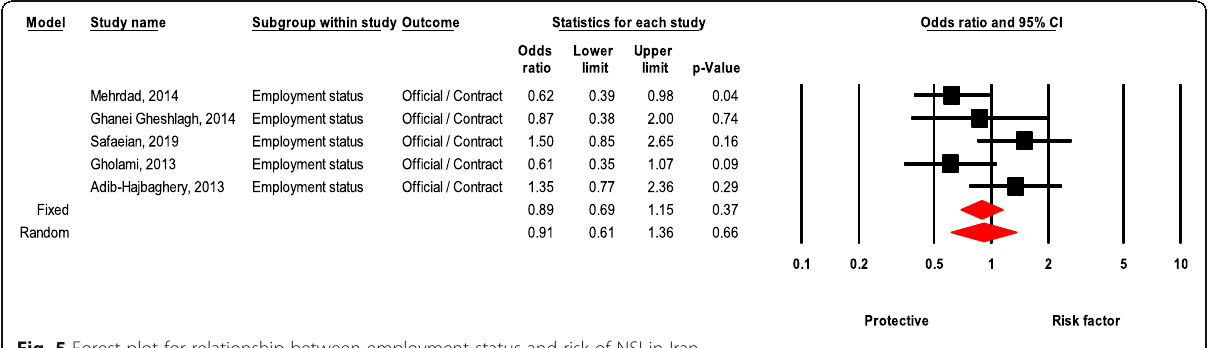
Fig. 5 Forest plot for relationship between employment status and risk of NSI in